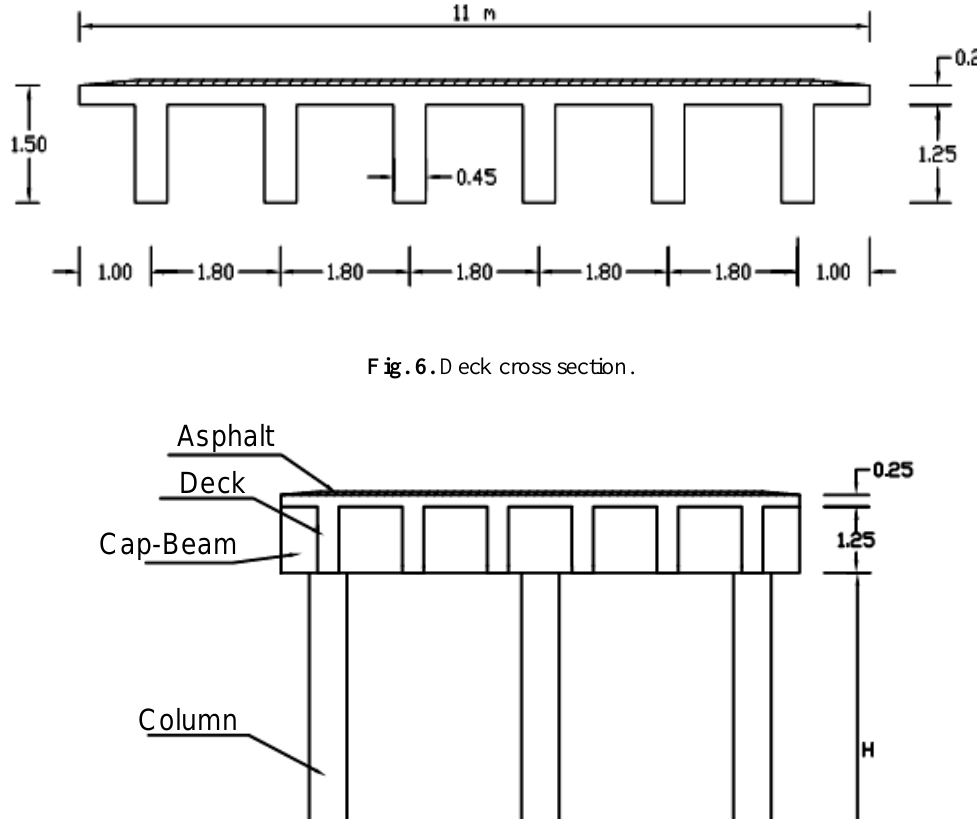
Fig. 7. Bridge cross section.